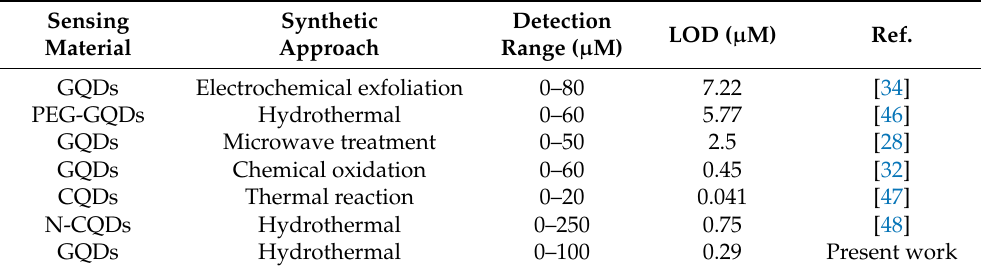
Table 1. A comparison of various reported studies with the present work for the limit of detection of Fe 3+ by